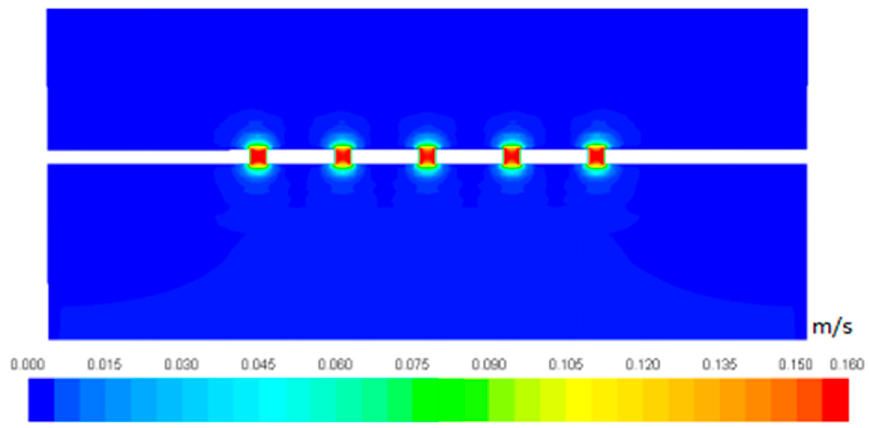
Figure 10. CFD obtained resonance frequencies of perforated plate No. 1–25 absorbers (as listed in Table 1).